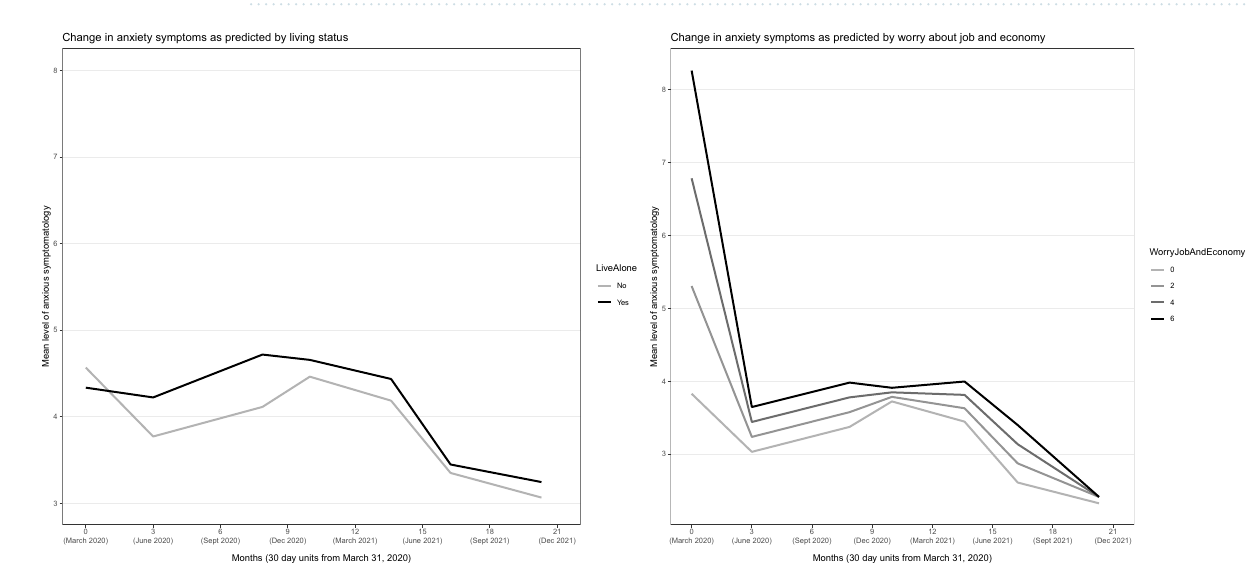
Figure 6. Anxiety across the 20-month observation period as predicted by living status and worry about job and economy. Controlled for the influence of all other variables in the